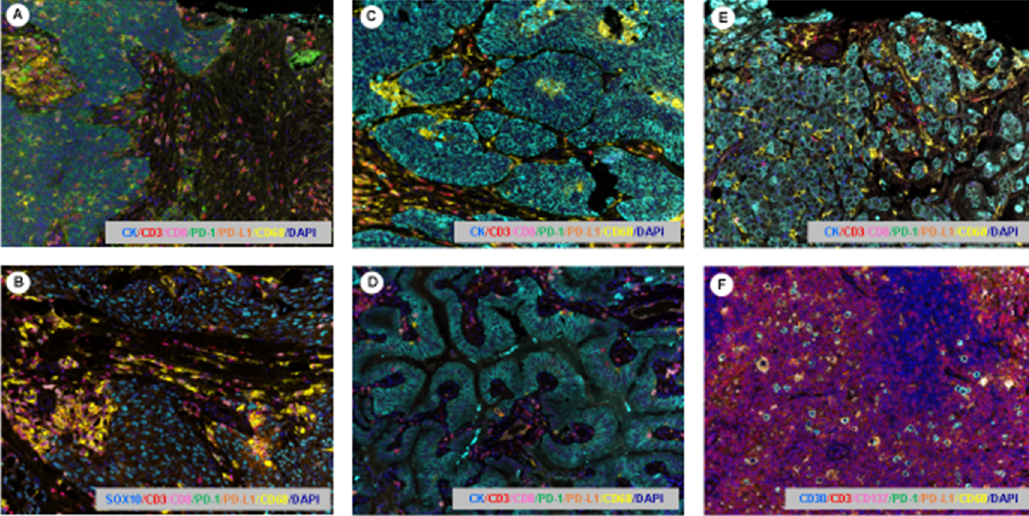
Figure 4. Multiplex immunoflorescencce microphotography. Images representing the immunoprofiling of different tumor types using the multiplexed tyramine signal amplification system: ( A ) esophageal squamous cell carcinoma, ( B ) malignant melanoma, ( C ) lung squamous cell carcinoma, ( D ) lung adenocarcinoma, ( E ) colorectal adenocarcinoma, ( F ) Hodgkin’s lymphoma. Scale bar: 200 ×